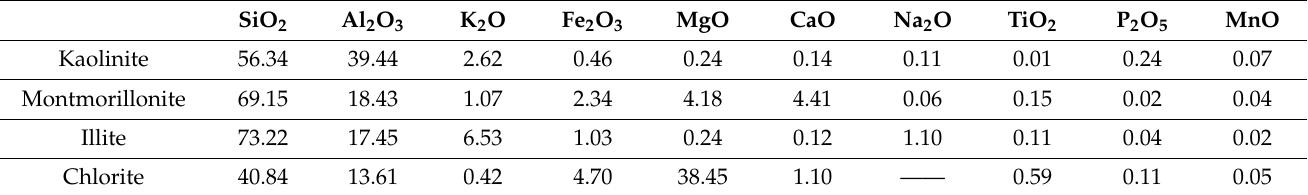
Table 4. XRF analysis results of clay minerals used in this study.